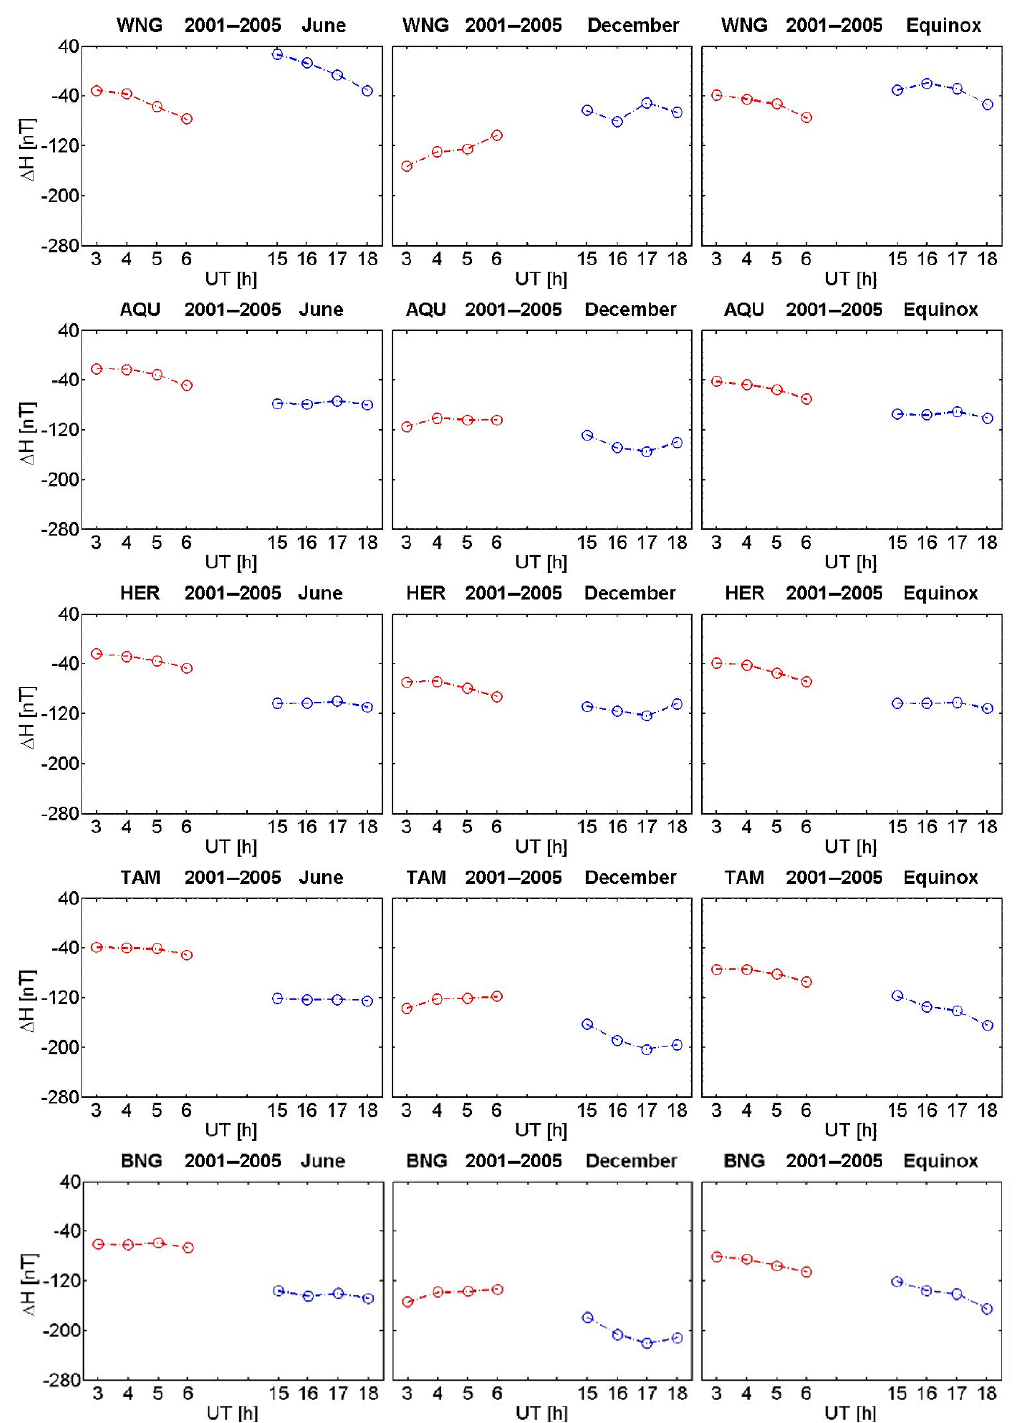
Figure 10. Mean deflections of the H component in the dawn and dusk sectors at five considered observatories separately for different seasons during active times (Kp > =